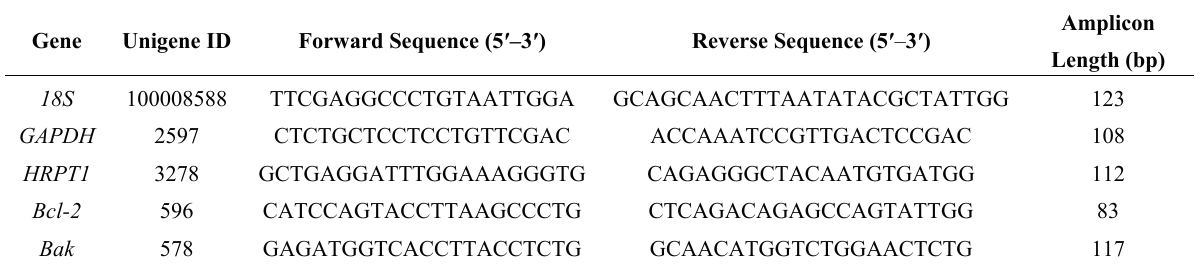
Table 1. Primer sequences used for each mRNA gene product and the corresponding size of the PCR amplicon